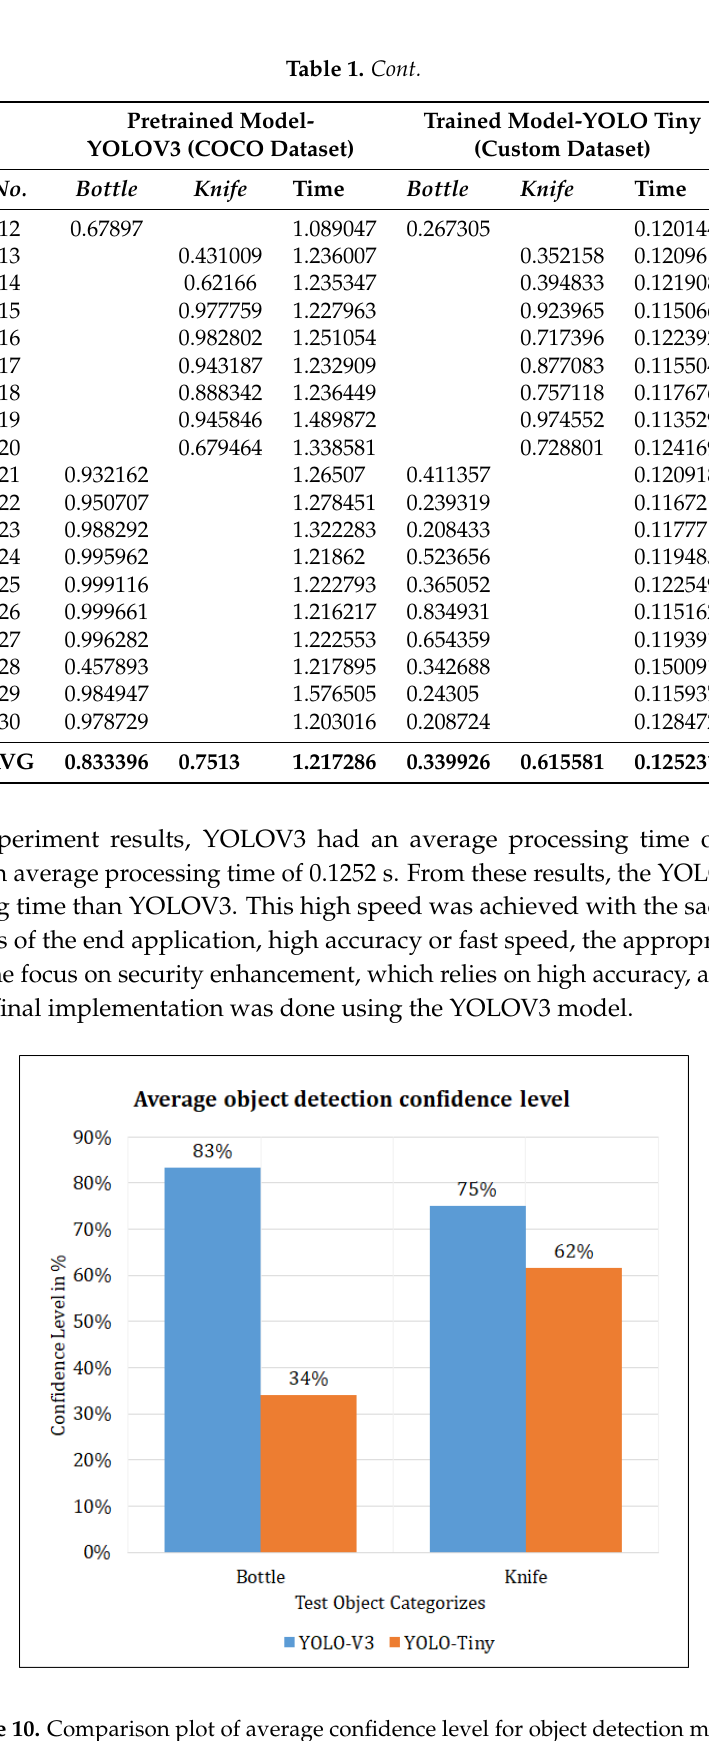
Figure 10. Comparison plot of average confidence level for object detection